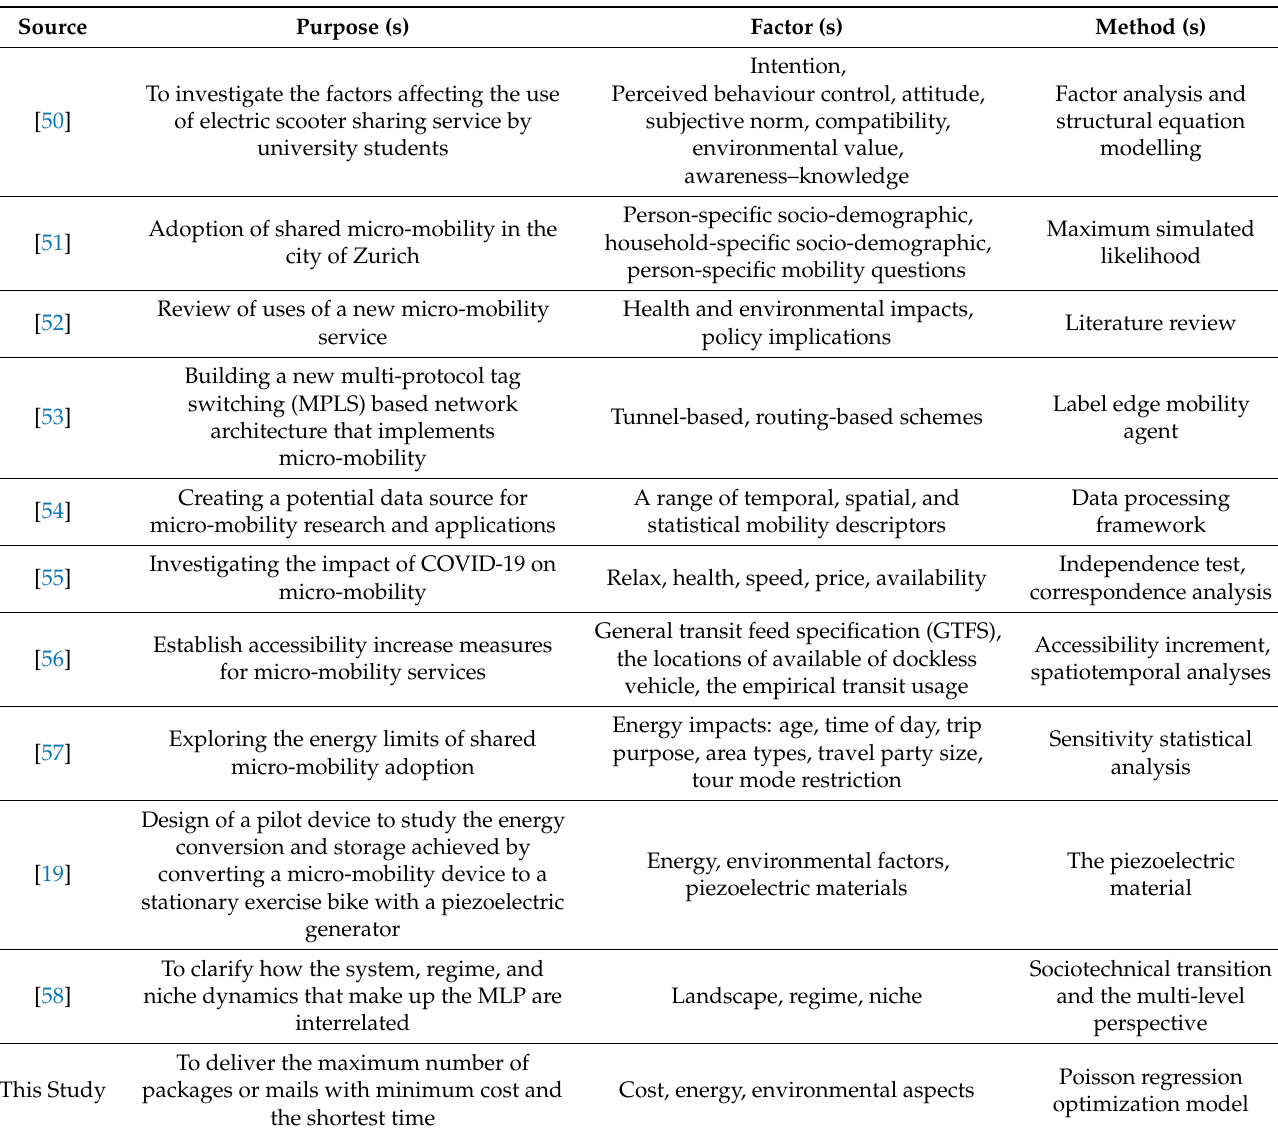
Table 1. Detailed information about the aims, methods, and factors of studies related to micro- mobility approaches and this